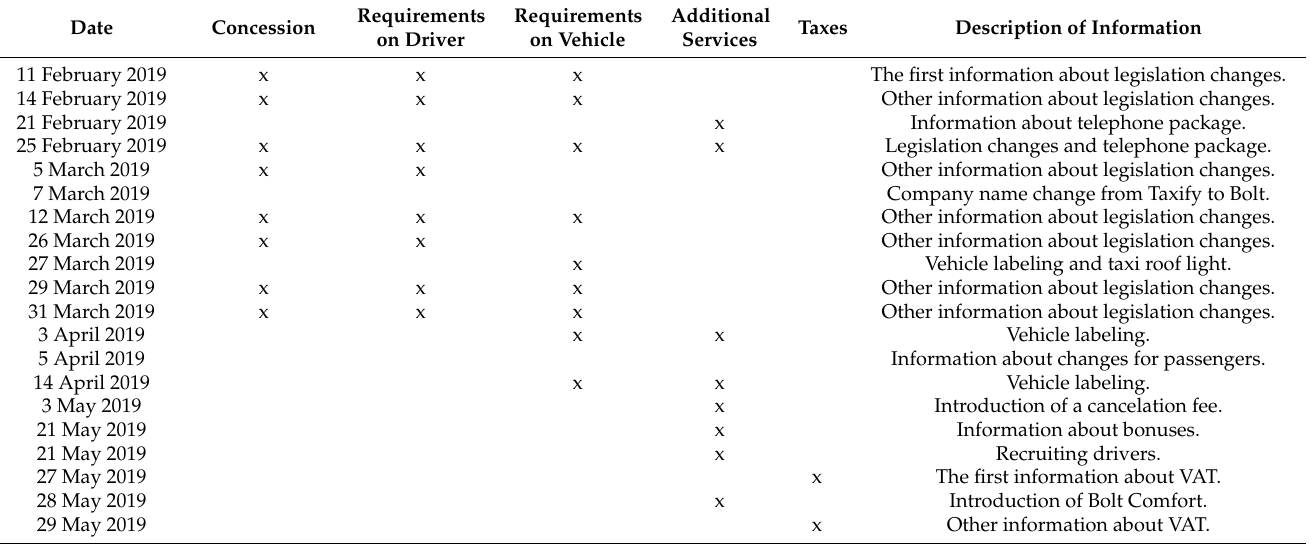
Table 6. Information for drivers in Bolt application. Processed by authors from own e-mail